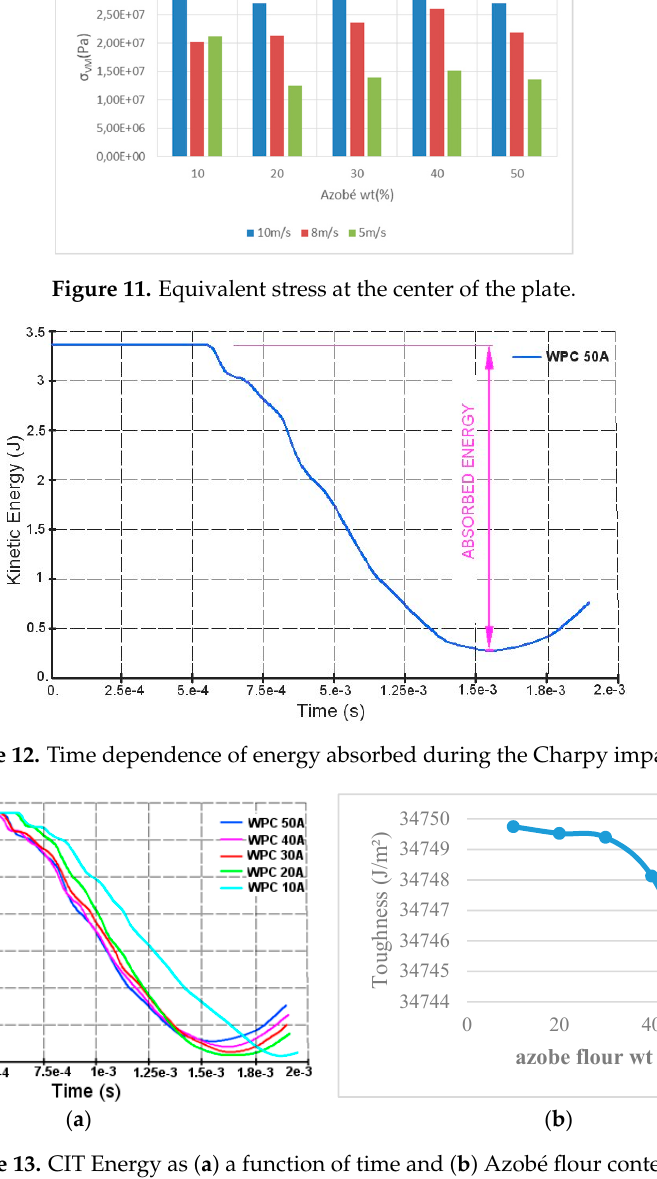
Figure 13. CIT Energy as ( a ) a function of time and ( b ) Azobé flour content.